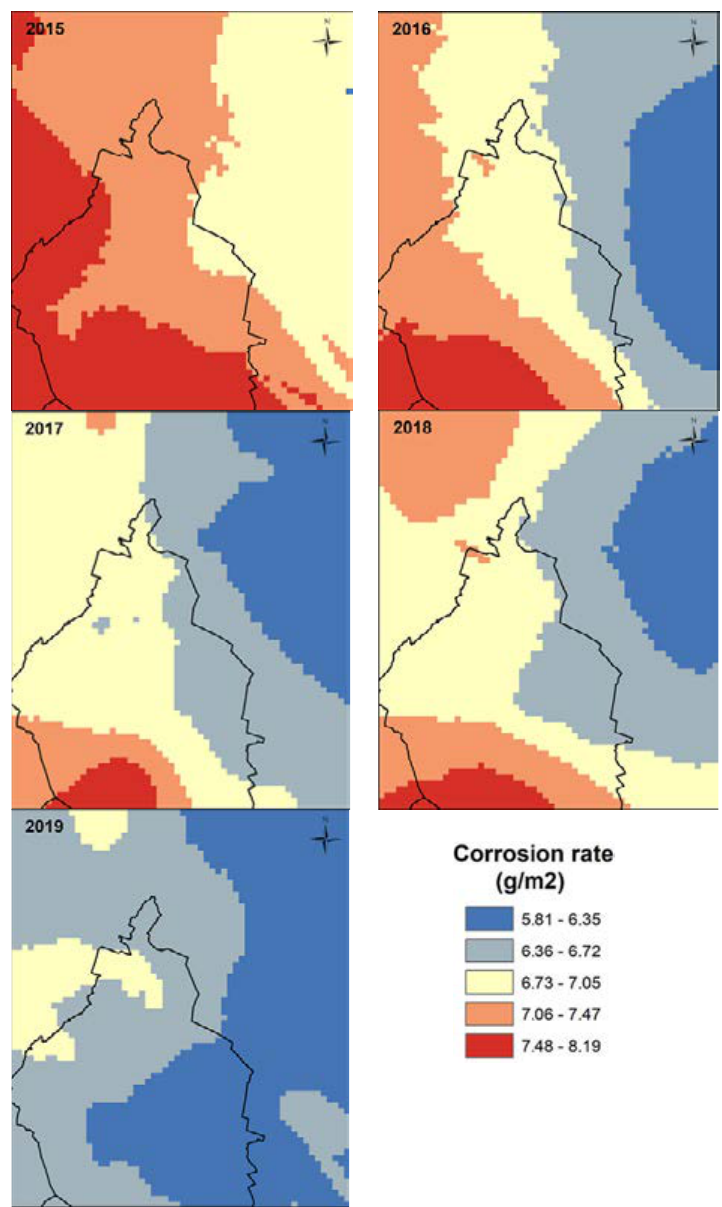
Fig. 4: Corrosion rate maps (g/m 2 ) of zinc, for a multi-pollutant situation for the period 2015-2019 in the MCMA